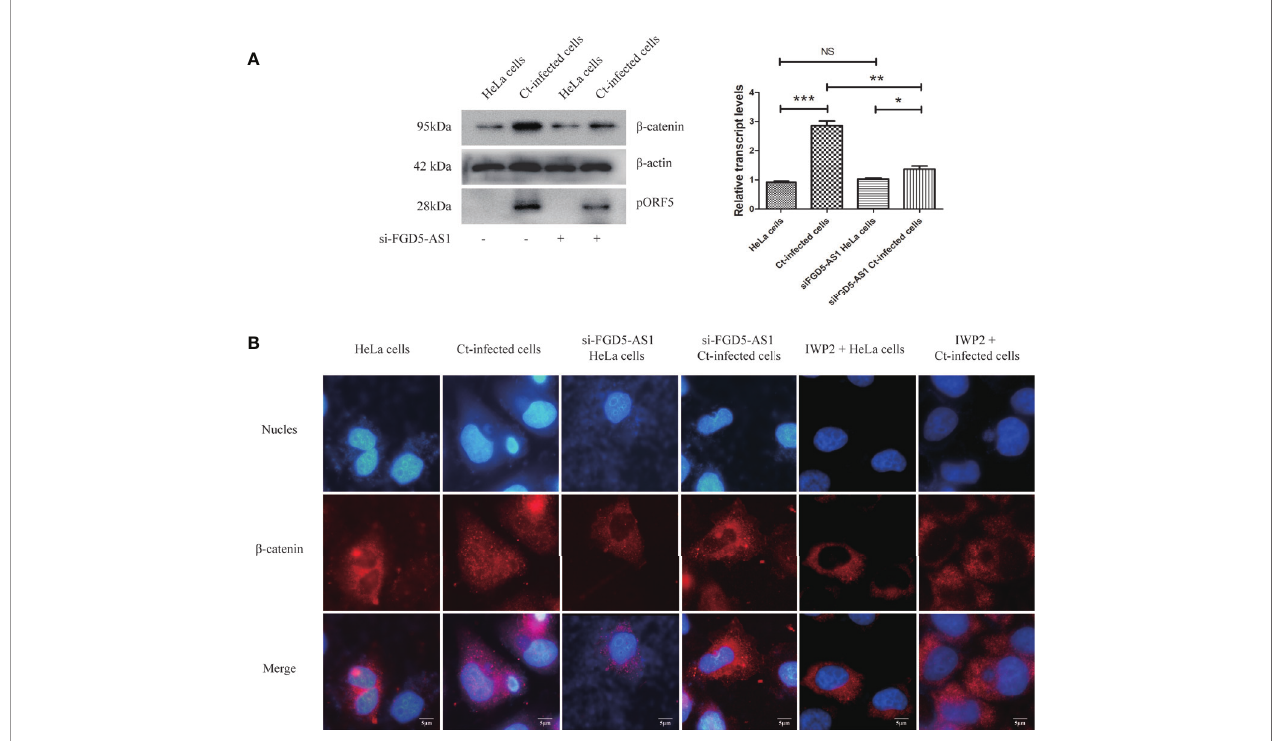
FIGURE 9 | Interference of lncRNA FGD5-AS1 inhibits Wnt/ b -catenin signaling pathway during Ct infection. (A) The protein expression level of b -catenin was measured by western blot in HeLa cells and Ct-infected cells after the interference of FGD5-AS1. The left panel is the corresponding gray value calculated by Quantity One. (B) The nuclear translocation of b -catenin in HeLa cells and Ct-infected cells after the interference of FGD5-AS1. * P < 0.05; ** P < 0.01; *** P < 0.001; NS, no signi fi